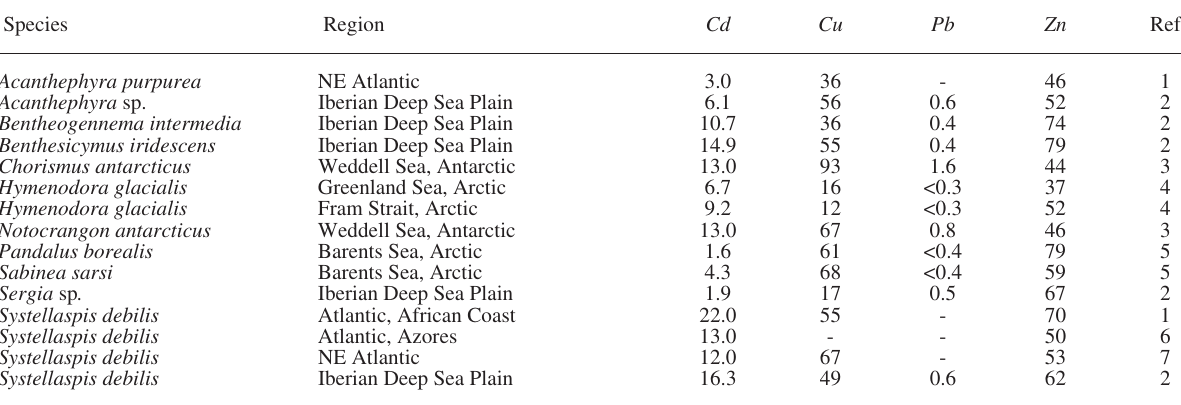
Table 4. – mean concentrations of the trace metals decapods from different regions of the world (mg kg -1 dW). species